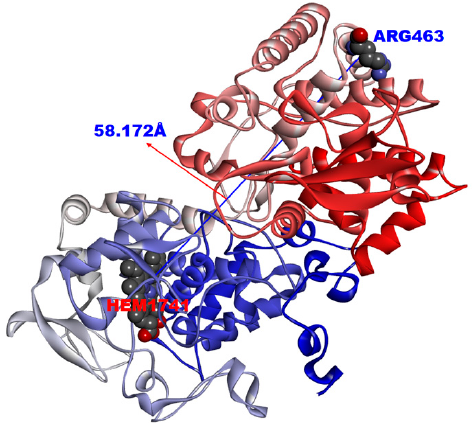
Figure 2. The distance of the active site of the KatG target and Arg463 residue (the distance was approximately 58.172 Å, far from drug binding site).